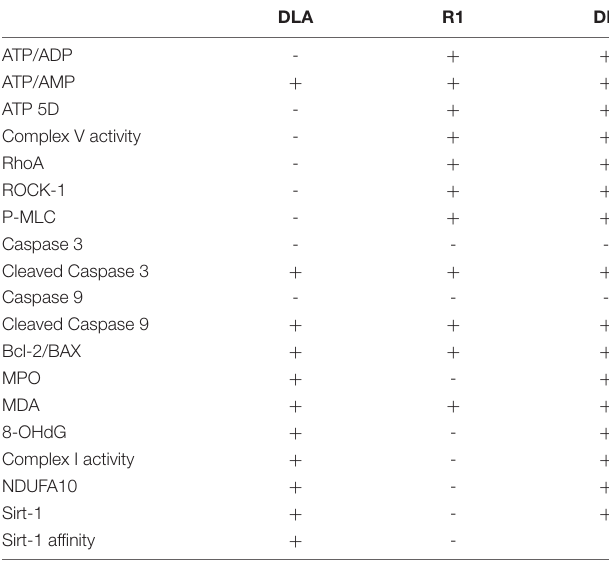
TABLE 1 | The effect of 3,4-dihydroxyl-phenyl lactic acid (DLA), notoginsenoside R1 (R1), and a combination of 3,4-dihydroxyl-phenyl lactic acid and notoginsenoside R1 (DR) on the parameters